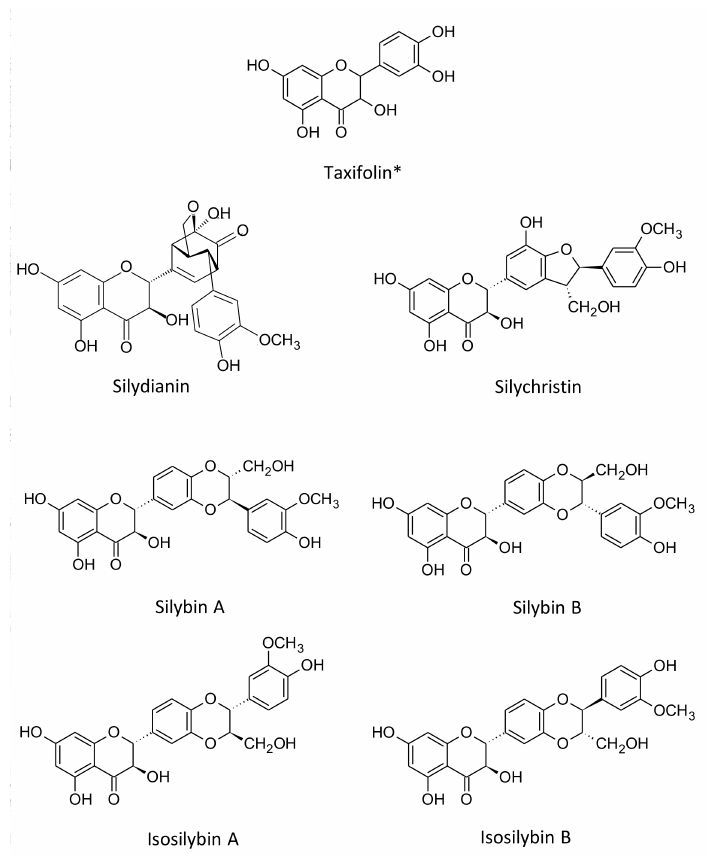
Figure 1. Chemical structure of the main six flavonolignans and one flavonoid (*) constituting the Silymarin mixture from Silybum marianum achene